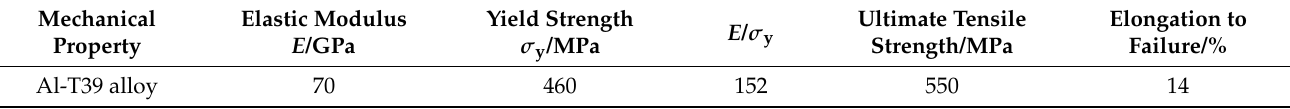
Figure 1. Schematic of laser peening process on a metal plate operating in a confined mode. Table 1. Mechanical properties of Al-2624 alloy in the T39 heat treatment